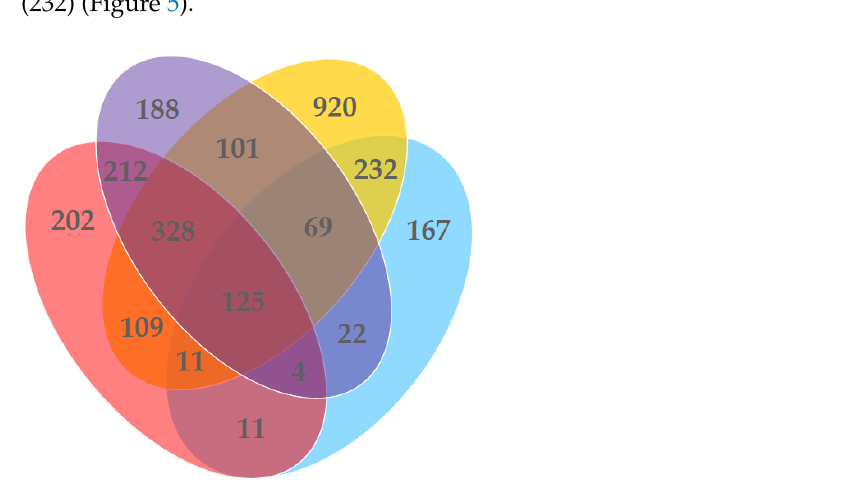
Figure 5. Venn diagram showing the diversity and overlap of fungal OTUs in different substrates, collected in Picea abies stands. Different colours represent different substrates: violet — needles, red — shoots, blue — roots, and yellow — soil.